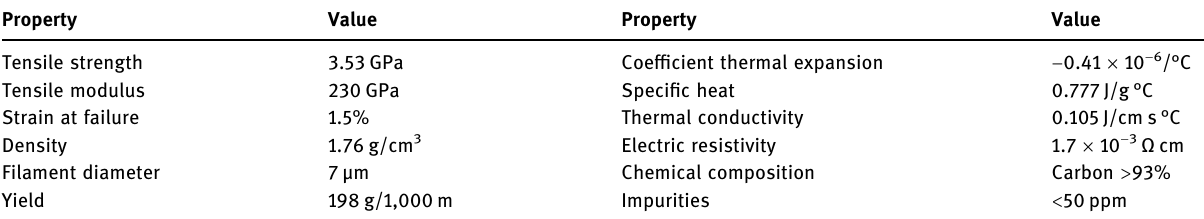
Table 1: The properties of the carbon fi ber used in this research ( concerning the datasheet issued by Toray Composite Materials, Inc. )